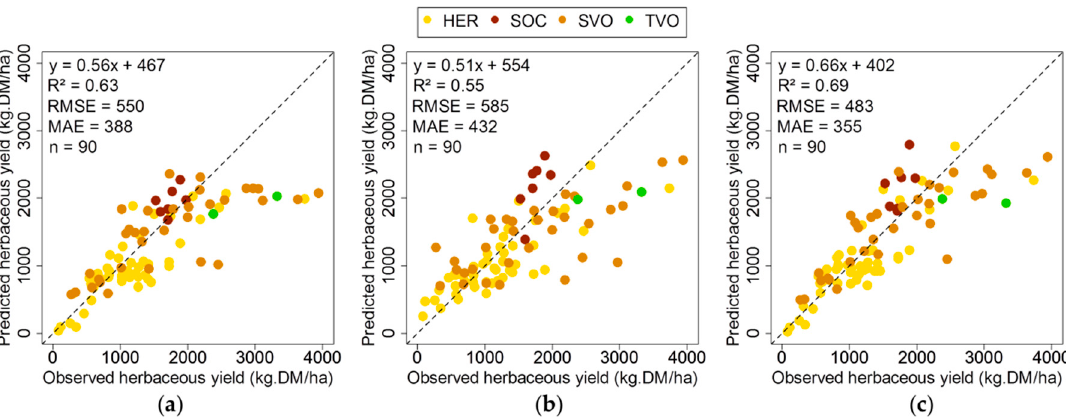
Figure 6. Accuracy assessment of the developed Cubist models: relationship between observed and predicted herbaceous yield for; ( a ) the VI-model; ( b ) the AGRO-model; ( c ) the VIAGRO-model.